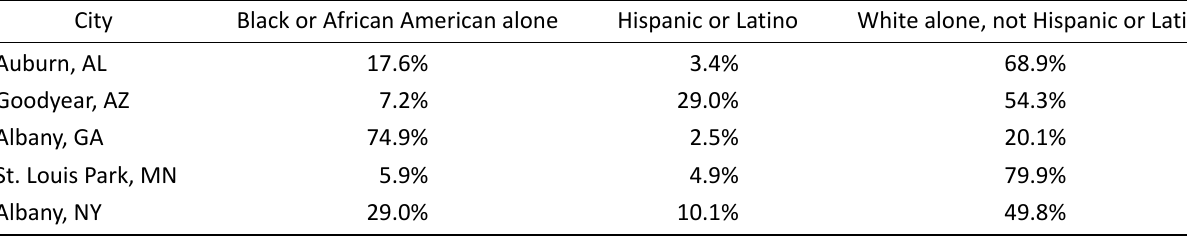
Table 2. Distribution of major race/ethnicity in the study cities.